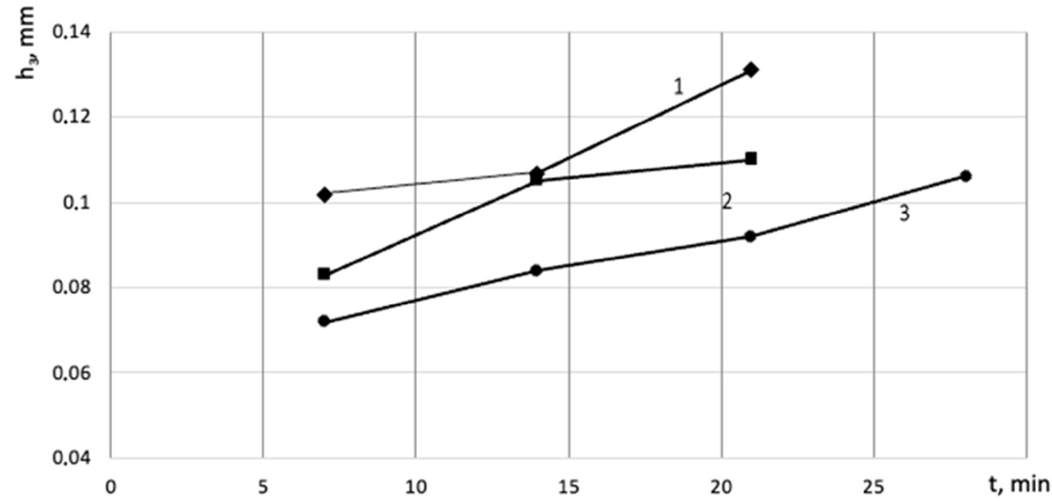
Figure 7. Graph of the dependency of wear vs. the cutting speed: 1— V = 50 m/min; 2— V = 35 m/min; 3— V = 25 m/min.